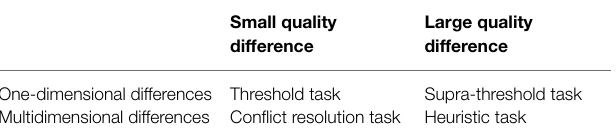
TABLE 1 | Image quality estimation tasks categorized according to the dimensionality of the differences and the magnitude of the overall quality